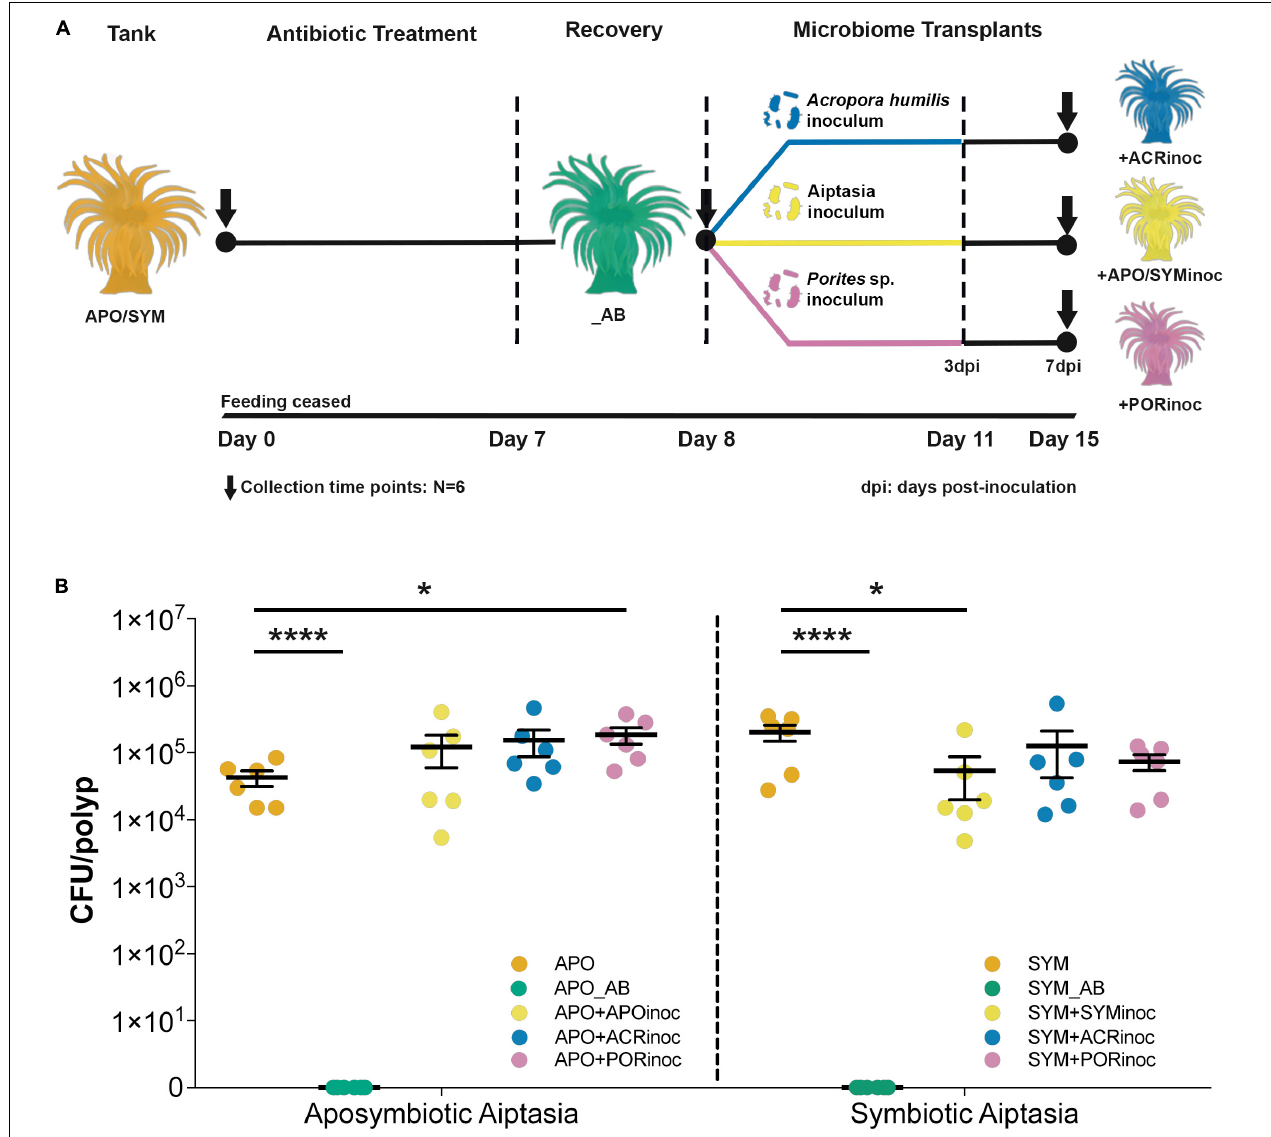
FIGURE 3 | Gnotobiotic Aiptasia, microbiome transplants, and carrying capacity of Aiptasia sea anemones. (A) Overview of the microbiome transplant experiment. Anemones underwent antibiotic treatment for 7 days, followed by a 1-day recovery. Animals were then inoculated with preparations of Acropora humilis , Porites sp., and Aiptasia microbiomes for 3 days, after which inocula were removed (water exchange) and animals were incubated for 4 additional days (total of 7 days). Dotted vertical lines denote a change in the external environment. (B) Carrying capacity of Aiptasia sea anemones. CFU counts were determined across all experimental conditions and for apo- (left) and symbiotic (right) anemones separately. Depicted is the mean and standard error for the respective experimental condition (* P ≤ 0.05; **** P < 0.0001). APO/SYM, apo- and symbiotic control anemones; APO_AB/SYM_AB, 7-day antibiotic-treated anemones with a subsequent 1-day recovery; APO+APOinoc, APO microbiome transplantation after antibiotic treatment; SYM+SYMinoc, SYM microbiome transplantation after antibiotic treatment; APO/SYM+ACRinoc, Acropora humilis microbiome transplantation after antibiotic treatment (7 days after inoculation); APO/SYM+PORinoc, Porites sp. microbiome transplantation after antibiotic treatment (7 days after